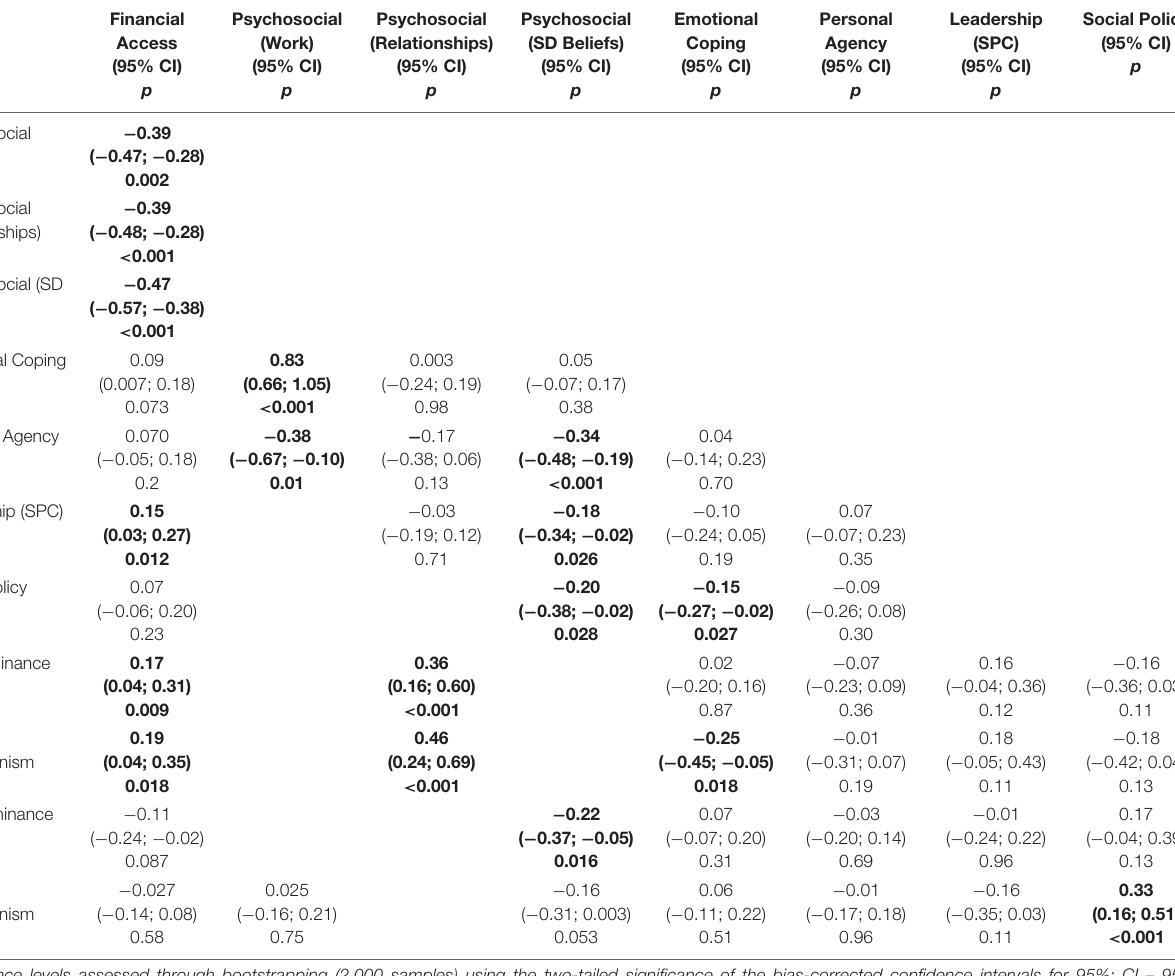
TABLE 4 | Direct effects for the mediation SEM Model